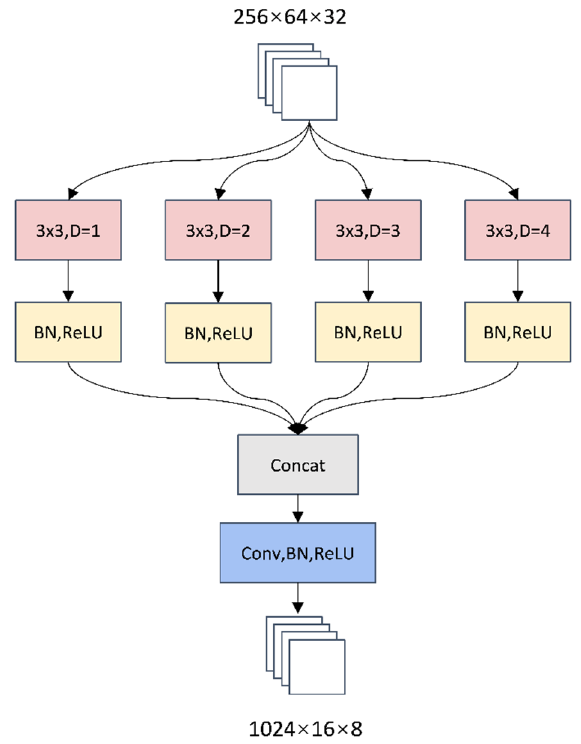
Figure 5. Context Information Fusion Module, where D represents dilation ratio and BN represents batch normalization. The input feature map is operated by using the convolution whose kernel size is 3 × 3 and the dilation ratios are 1, 2, 3, and 4, respectively.